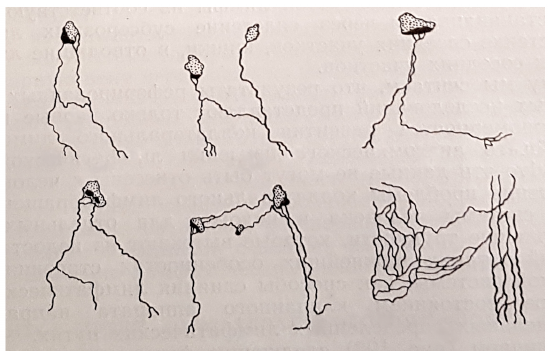
Figure 1. Various types of connections characterizing lymphatic vessel networks (from [18]).